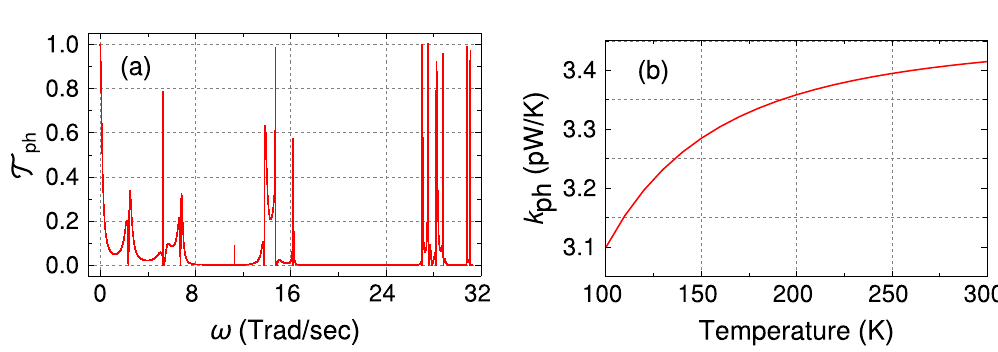
Figure 6. ( a ) Transmission coefficient T (red color) as a function of energy E along with the energy eigenvalues (cyan color). At each eigenvalue, we draw a single vertical line of unit magnitude for better visibility of the energy eigen spectrum. ( b ) Electrical conductance G , ( c ) thermopower S , and ( d ) thermal conductivity due to electrons k e as a function of the Fermi energy E F . Here a 5th generation SPG is considered and the light 0 and A 2 . parameters are A x y = =